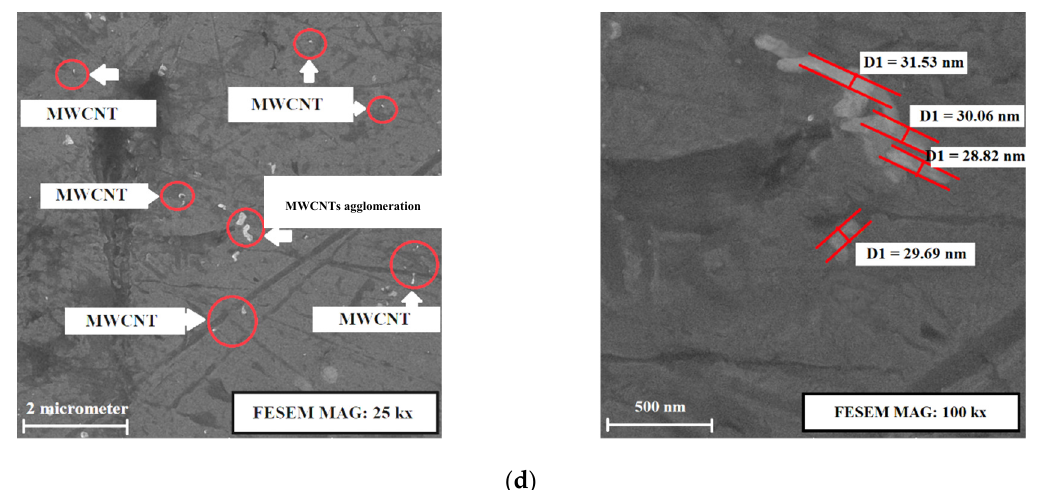
Figure 4. FESEM pictures of ( a ) Al 0.2% MWCNTs; ( b ) Al 0.2% coated-MWCNTs; ( c ) Al 0.5% MWCNTs; ( d ) Al 1% MWCNTs–FESEM images.